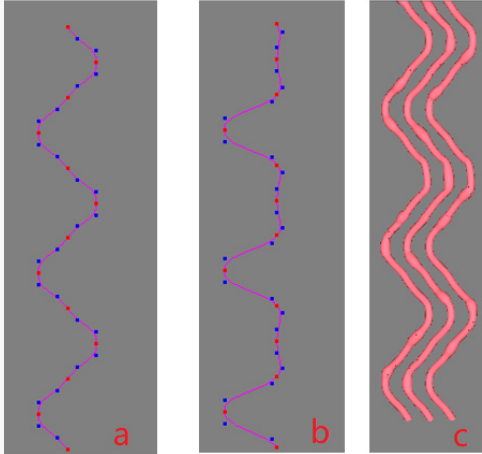
Figure 14. Different target curves and different mapping starts. ( a ) Target curve a. ( b ) Target curve b. ( c ) Mapping effects onto the target curve a from the source yarn at different mapping starts.